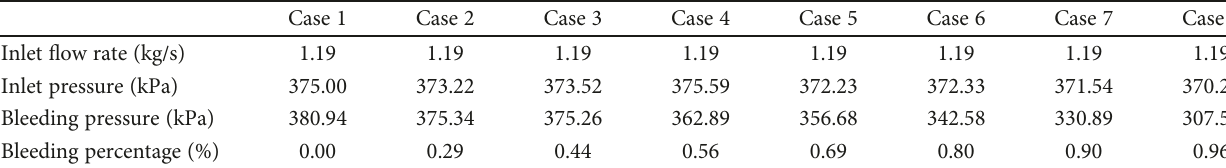
Table 2: Operating conditions ( H